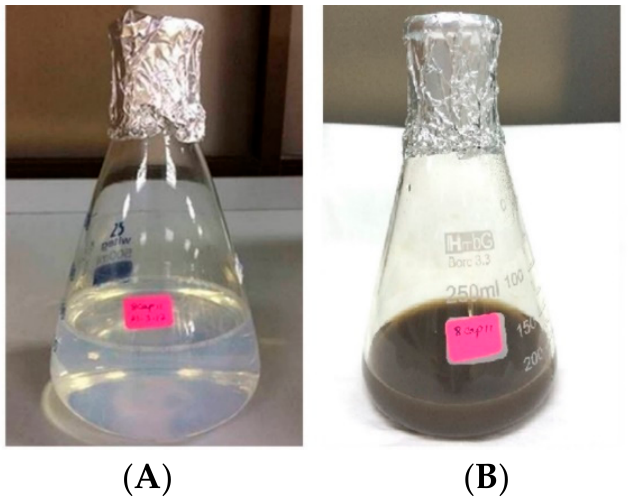
Figure 1. Visible colour change of the reaction mixture before ( A ) and after ( B ) sunlight exposure.